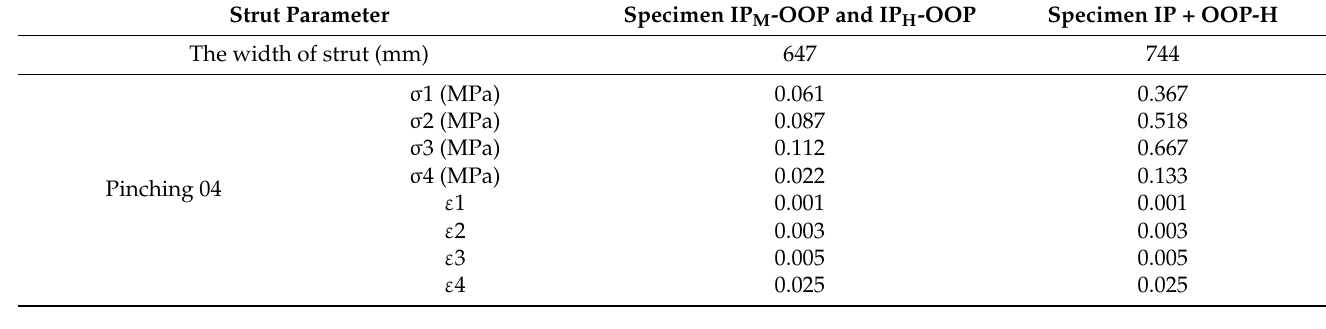
Figure 5. The nonlinear behavior of the central element: ( a ) the force – displacement relationship; ( b ) the Pinching 04 model. Table 7. Modeling parameters of the elastic–plastic central strut. Strut Parameter